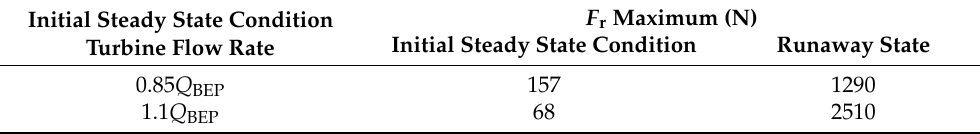
Table 4. Comparison of the maximum values of Fr before and after the turbine